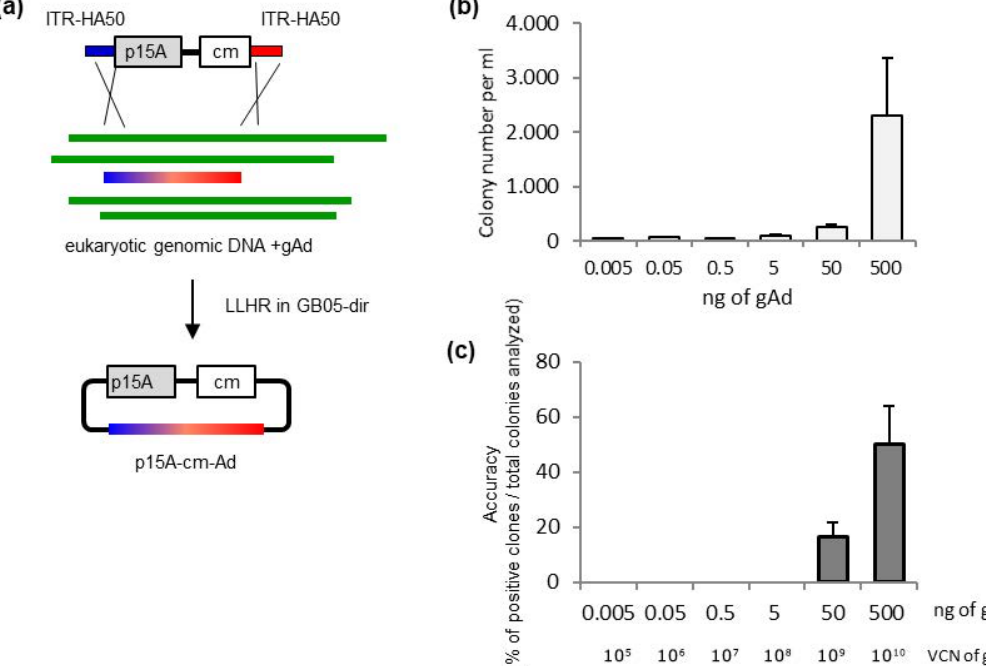
Figure 2. Influence of adenoviral genome (gAd) amount in cell / virus mixture on cloning efficiency. ( a ) Schematic diagram illustrating the setting for direct cloning of gAd from a DNA mixture with eukaryotic genomic DNA from A549 cells. The linear p15A-cm vector and adenoviral genome have identical sequences at both ends (ITR-HA) as homology arms for direct cloning. Five hundred nanograms of the linear vector flanked by 50-bp homology arms (p15A-cmAd9HA) was co-transformed with either 0.005, 0.05, 0.5, 5, 50, or 500 ng of gAd9 diluted in either 500, 499.9, 499.5, 495, 450, or 0.005 ng eukaryotic genomic DNA. The cloning efficiency is expressed by obtained colony numbers ( b ), while accuracy via percentage of positive colonies detected by colony PCR (Figure S2) ( c ). VCN, virus genome copy number, calculated in an online DNA copies calculator from URI Genomics and Sequencing Center (http: // cels.uri.edu / gsc /